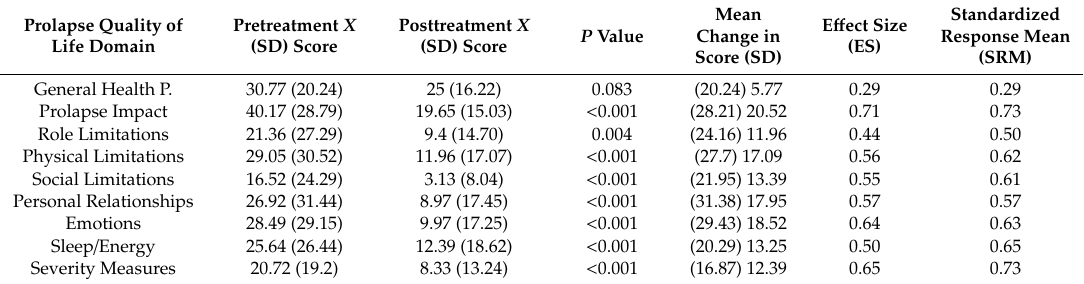
Table 5. P-QoL mean change in scores and responsiveness (N =